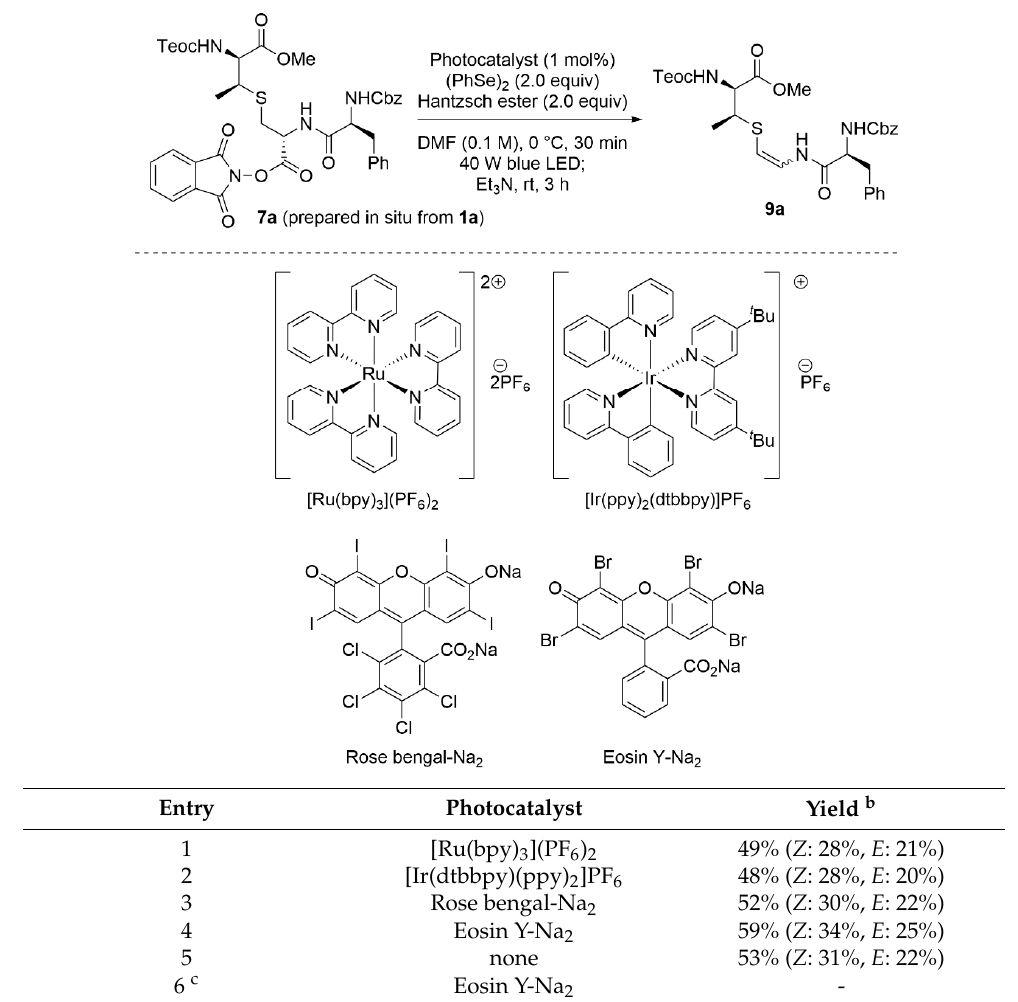
Table 1. Preliminary screening of photocatalysts for selenoetherification/ β -elimination a .